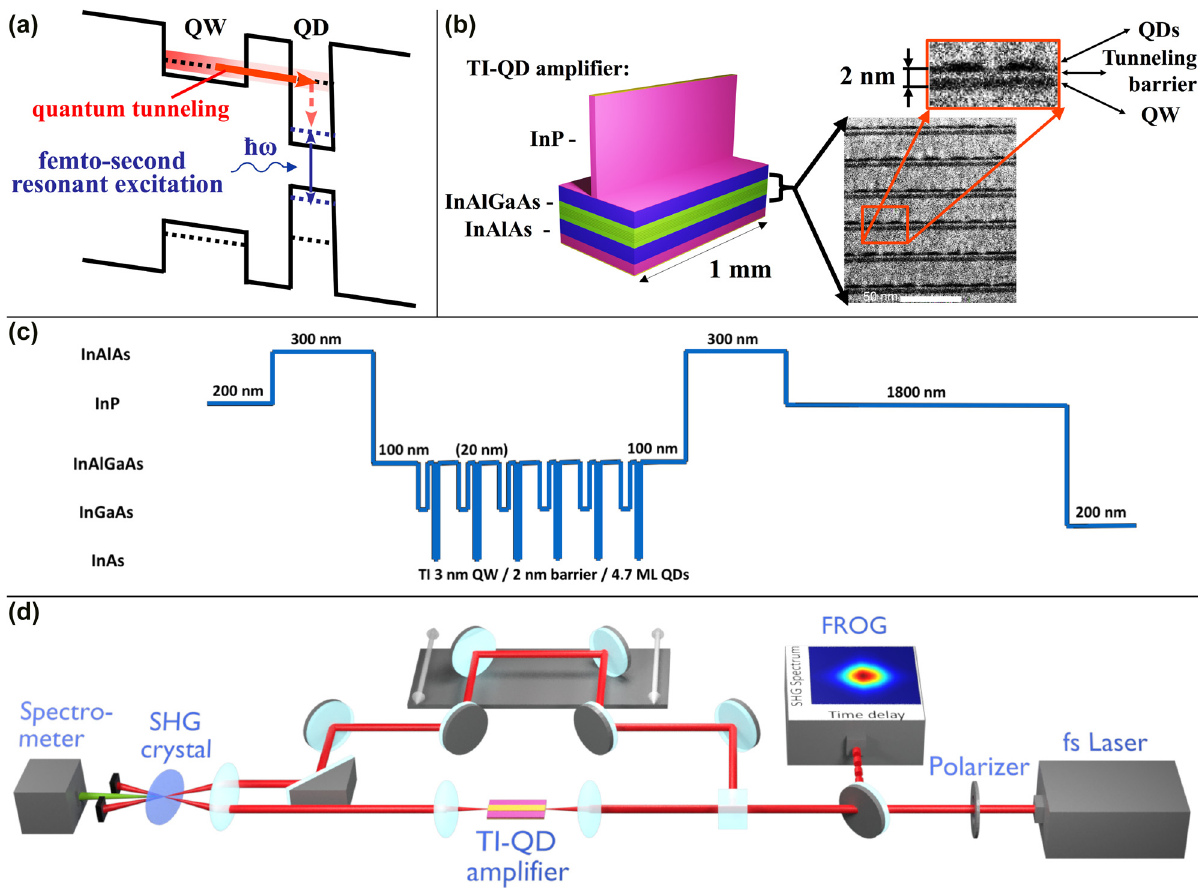
Figure 1: Coherent light-matter interaction in room temperature TI-QD amplifiers. (a) Schematic description of resonant tunneling and the coherent light–matter interaction between QDs and a resonant optical excitation. (b) A TI-QD amplifier comprising a ridge waveguide structure. The inset shows a high-resolution transmission electron microscope cross section of the six QDs–QW pairs of layers with the barriers separating them. (c) Energy band diagram of the laser structure comprising six layers of QD–QW pairs. (d) Schematic of the experimental XFROG system.